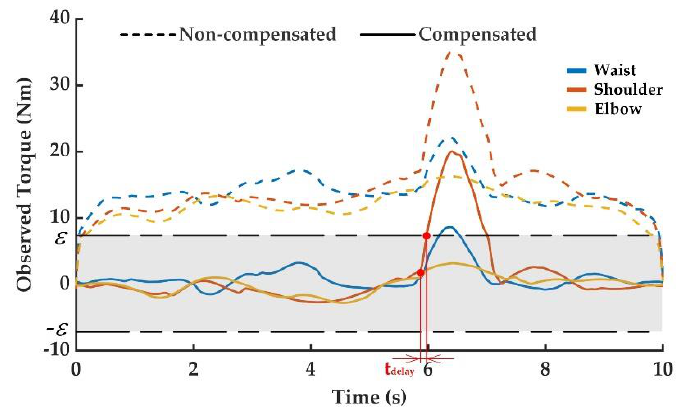
Figure 6. External torque observation in the second collision experiment.